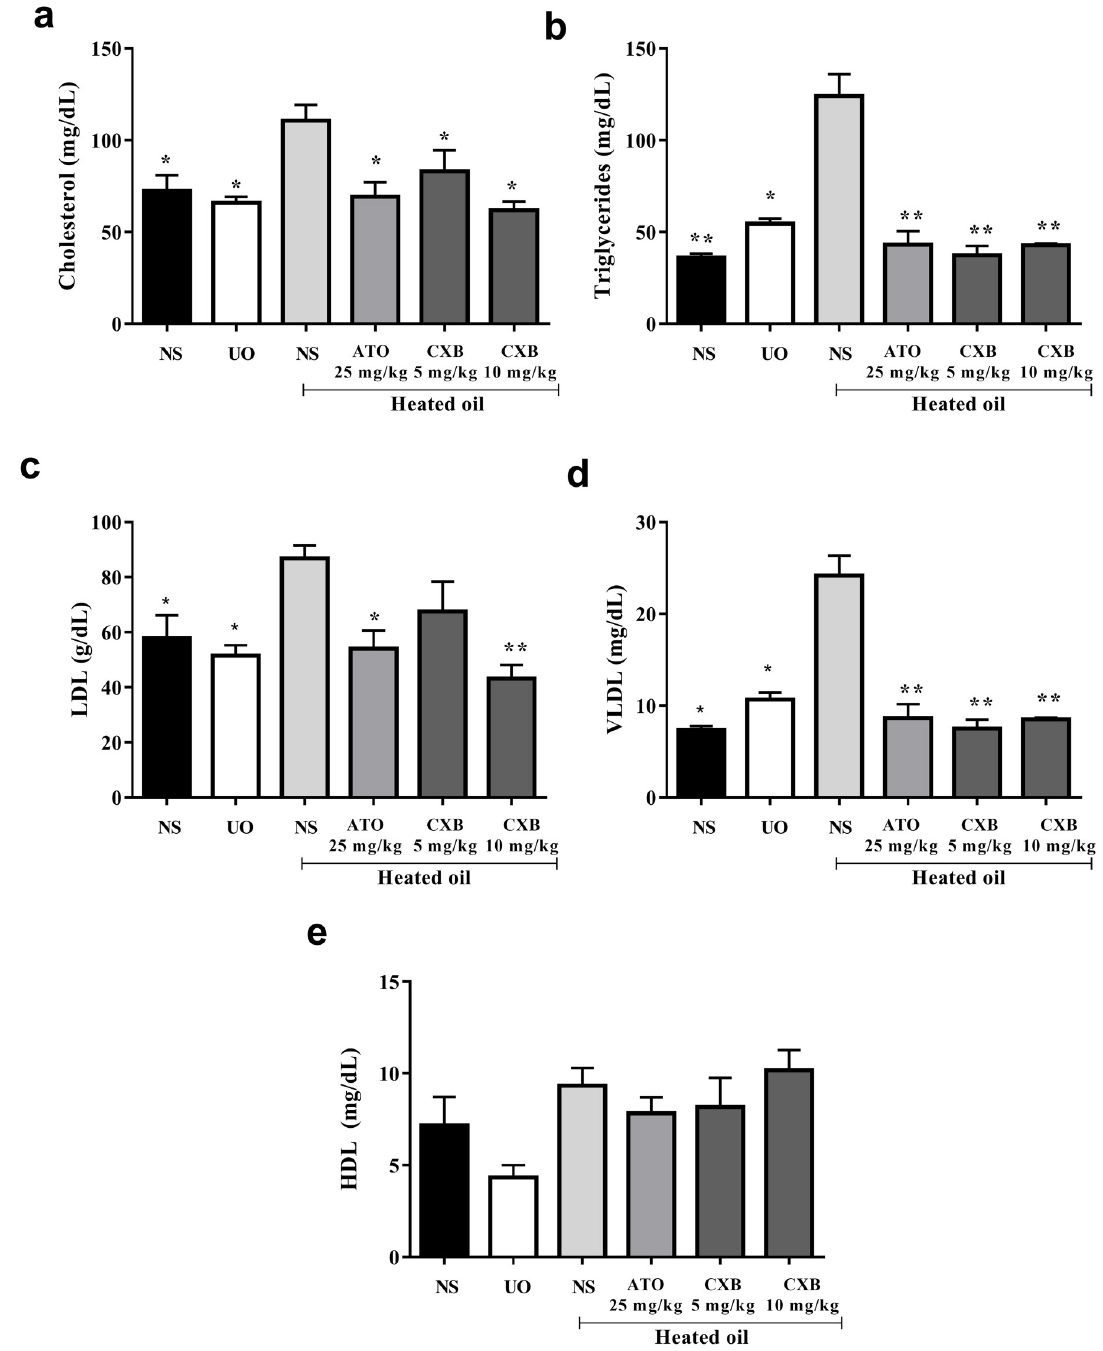
Fig 5. Effect of celecoxib (CXB 5 and 10 mg/kg), atorvastatin (ATO 25 mg/kg) on serum lipid parameters such as (a) cholesterol (b) triglycrides (c) low density lipoprotein (d) very low density lipoprotein and (e) high density lipoprotein cholesterol in overheated- oil induced hyperlipidaemia in Sprague-Dawley rats. Values are expressed as mean ± SEM (n = 6). The symbols � and �� represents significant differences ( P < 0.05 and P < 0.01 respectively) between treatment groups and heated oil only group (all were compared using one-way ANOVA followed by Newman-Keuls’ post hoc